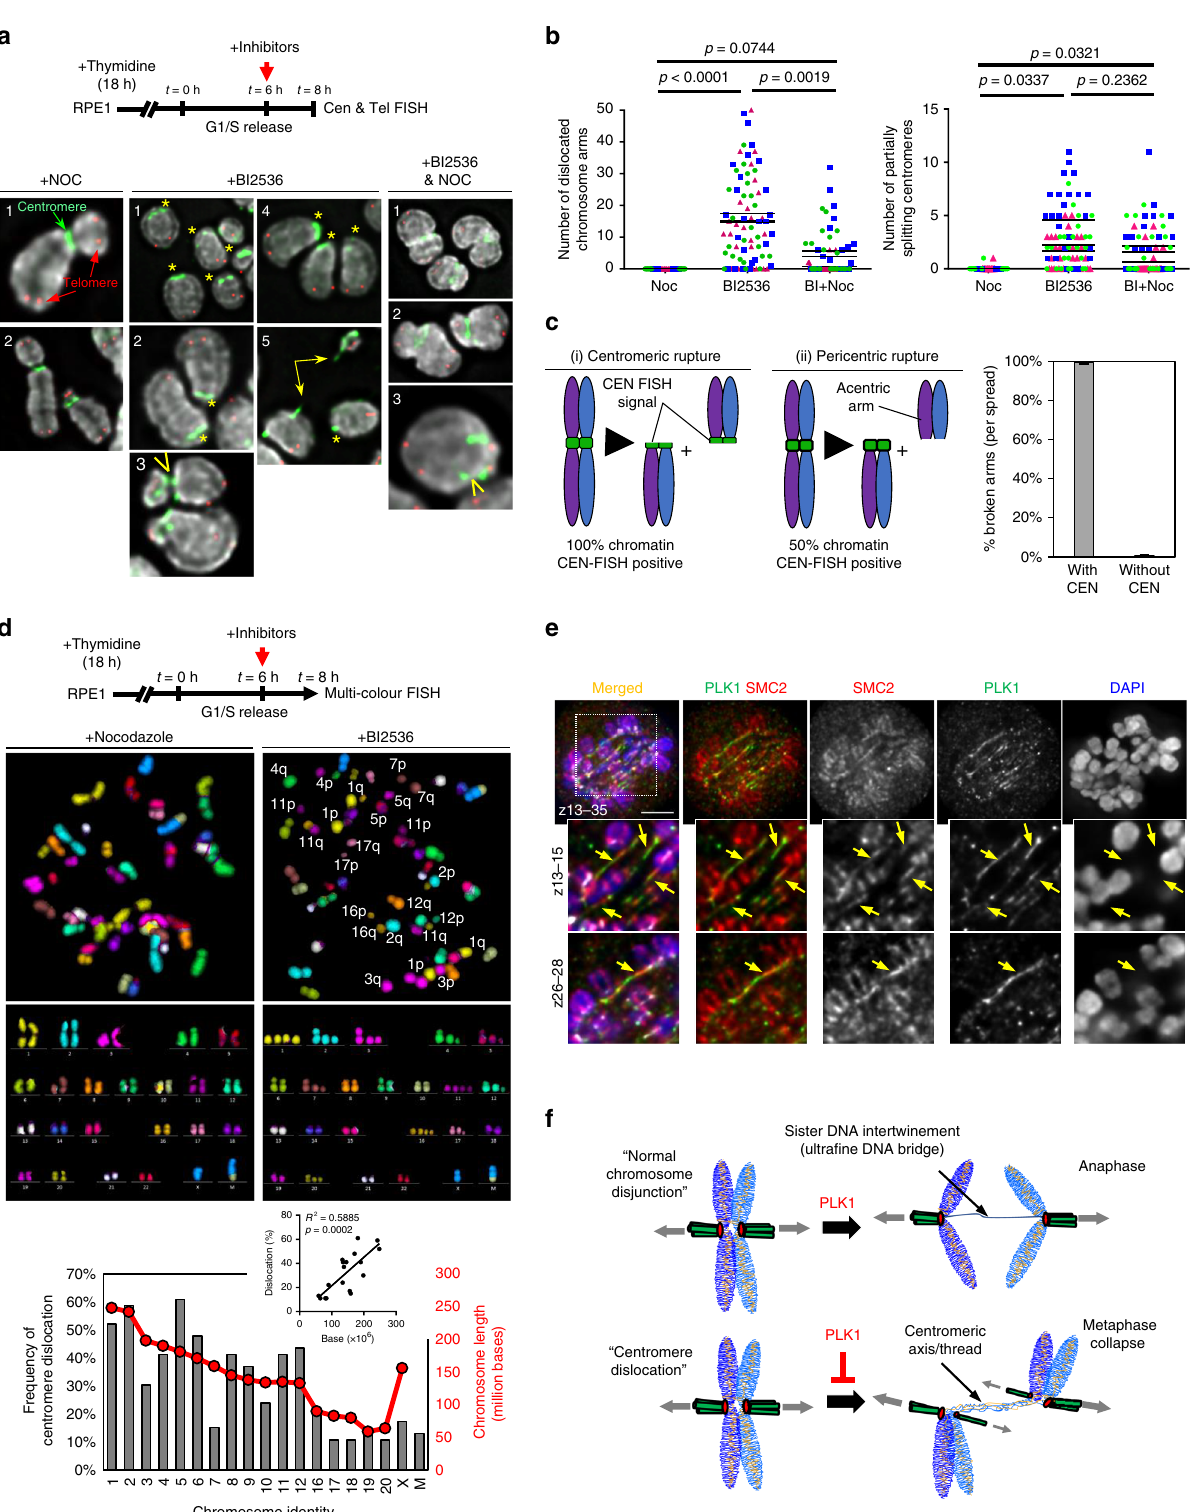
bipolar spindle tensions and the core axis is transformed into an ultra fi ne DNA threadlike structure. Indeed, we were able to detect condensin, a chromosome axial element, associating along the stretched DNA threads (Fig. 3e; arrows). The disintegration of centromeres therefore causes whole-chromosome arm splitting and explains why cells simultaneously lose their metaphase alignment (Fig. 3f). NATURE COMMUNICATIONS| (2019) 10:2861